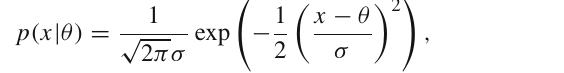
is the product of the distribution p ( x | θ) in Eq. (5) with a flat prior p (θ) = 1 on the range θ ∈ [ 0 , 1 ] . We can then overlay ˆ f ( x , θ) given by the best-fit values of μ m , μ b , and σ . We ˆ f ( x , θ) see that the overall shapes of the two are similar, but is more concentrated at intermediate values of θ . Integrating (cid:20) ˆ f ( x | θ = 0 ) dx is clearly along vertical lines, the value (cid:20) (cid:20) ˆ f ( x | θ = 0 . 5 ) dx , while the values p ( x | θ) less than